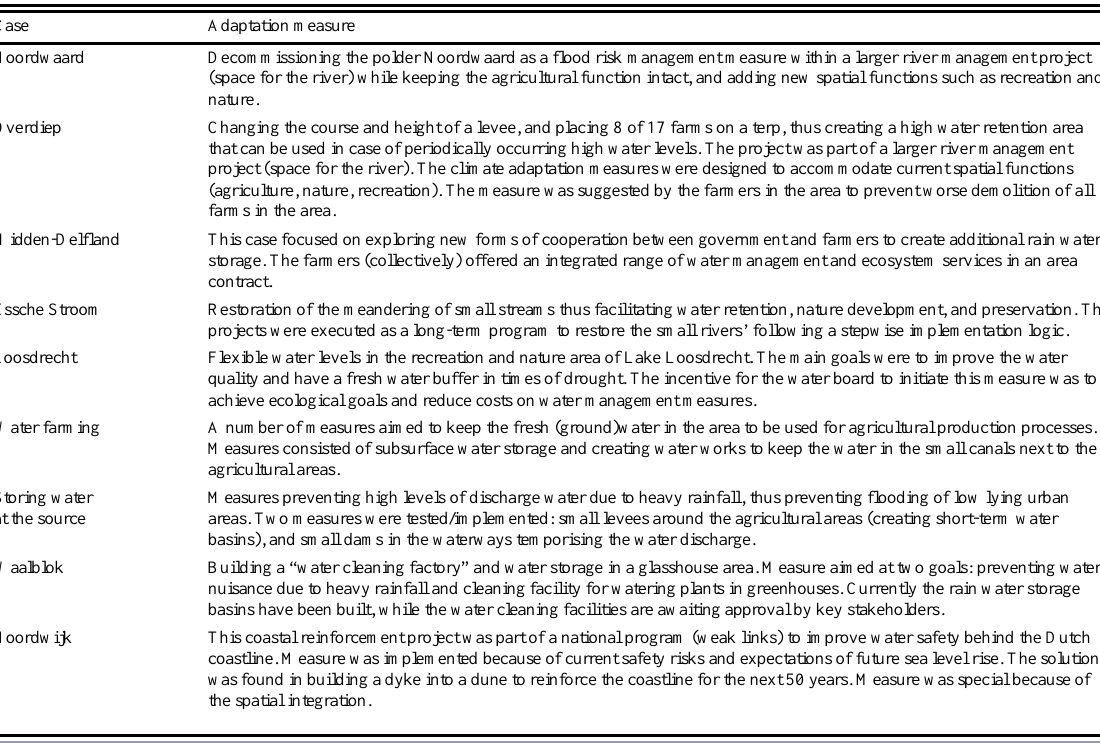
Table 3. Cases: climate adaptation measures.